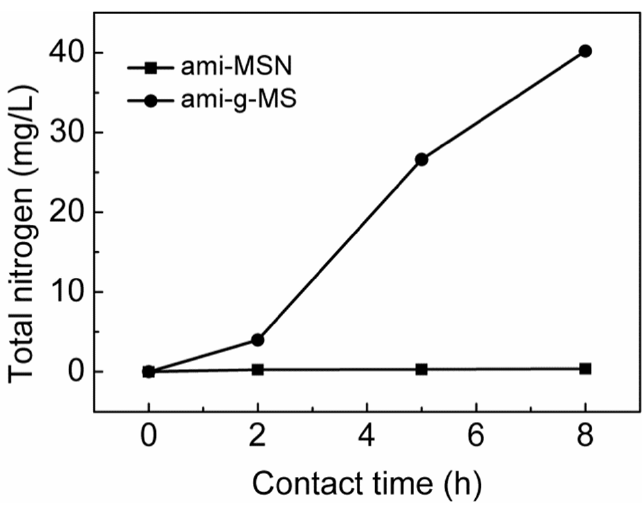
Figure 4. Total nitrogen content of solutions at different contact time for materials.